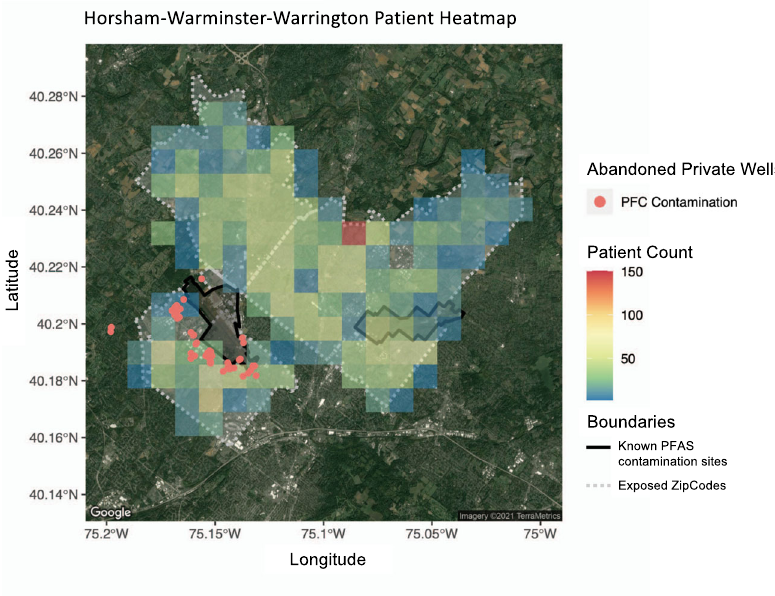
Fig. 2 Heatmap detailing a subset of Penn Medicine patients living in Horsham-Warminster-Warrington, PA along with PFAS contamination sites and contaminated private wells. Select points are censored. The PFAS contaminated private wells are denoted with red points. The ZIP code boundaries are shown in gray-dashed bordering. Boundaries of the Former Naval Air Station Joint Reserve Base (NASJRB) and Former Naval Air Warfare Center (NAWC) are shown with black solid line bordering. The underlying base map is generated from the R package ggmap that uses a map from Maps Static API provided by Google Maps Platform. Additional layers and annotation provided by us.